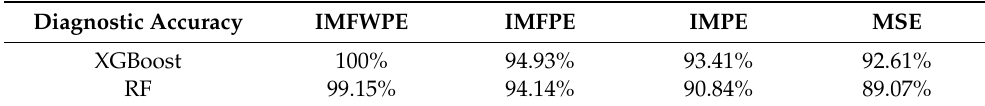
Table 2. Fault diagnosis results of different